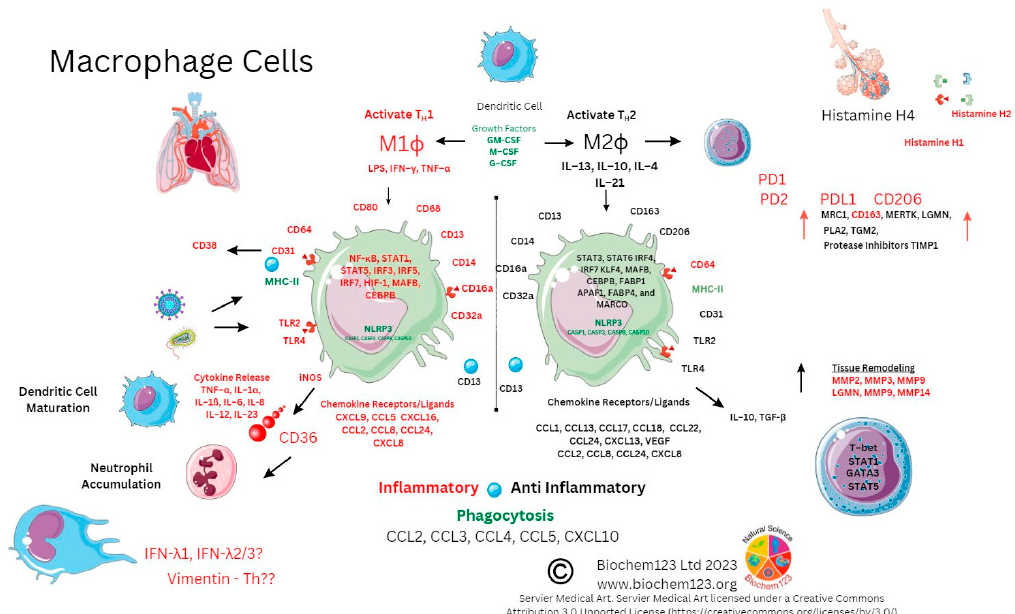
Figure 7. Macrophage phenotypes during